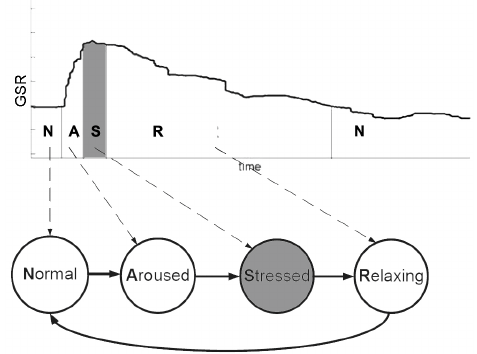
Figure 3. (Adapted from Bakker et al.)—‘An example of acute stress pattern observed from GSR data and how it can be mapped to the symbolic (time-stamped) representation of person’s stress’ [40].